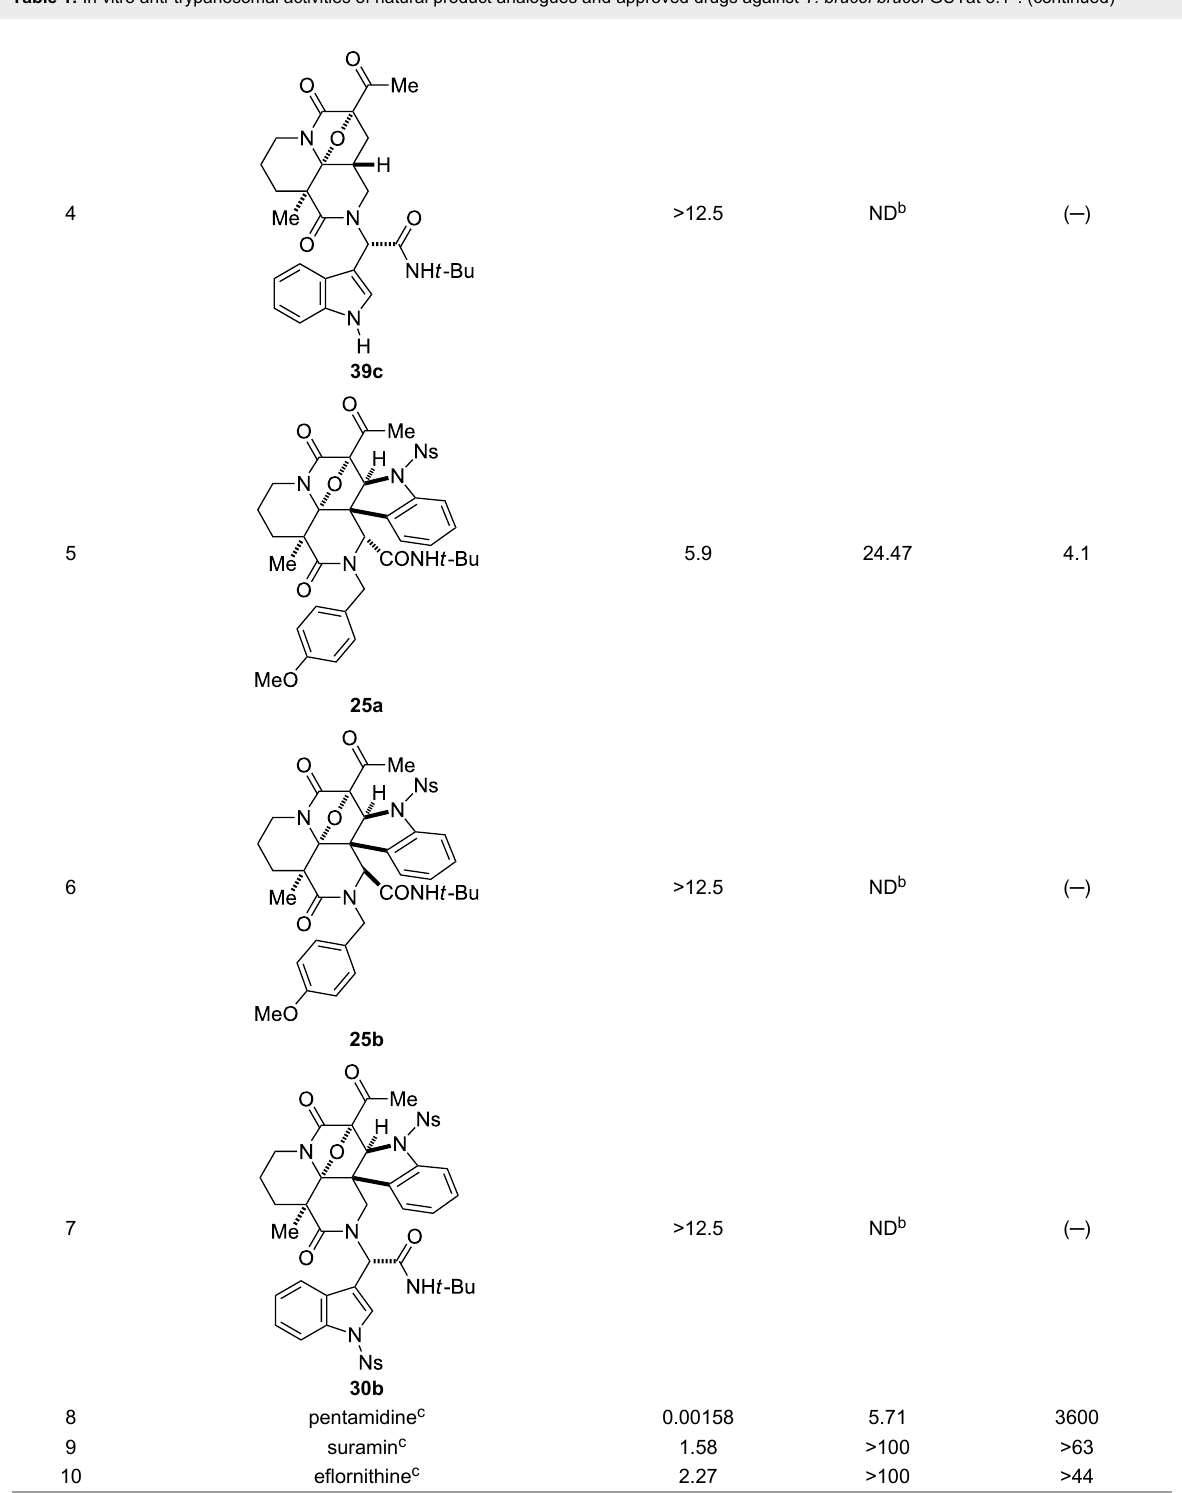
Table 1: In vitro anti-trypanosomal activities of natural product analogues and approved drugs against T. brucei brucei GUTat 3.1 a .